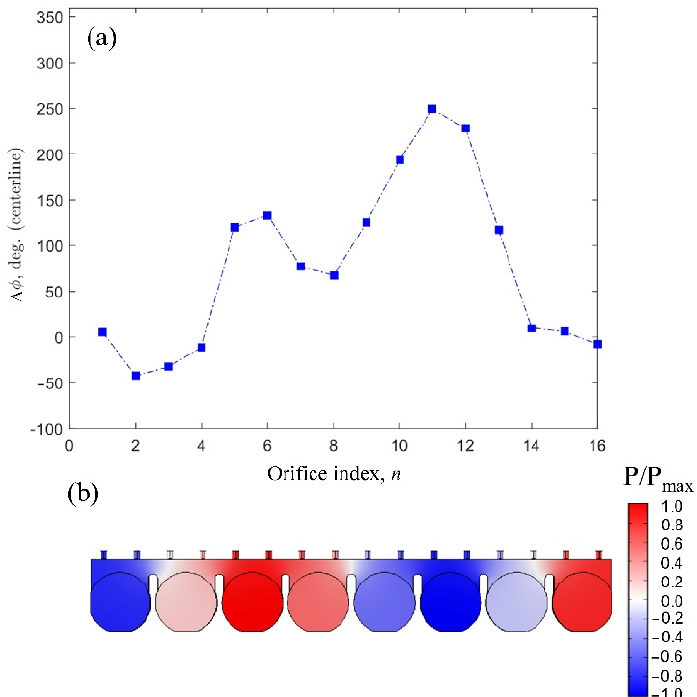
Figure 11. ( a ) Variation of the phase-angle difference between the phase-averaged peak jet velocity at the orifice centre and the peak input excitation along all 16 orifices for the excitation of the unified-cavity configuration at the frequency of f e = 800 Hz and ( b ) the variation of the instantaneous acoustic pressure within the unified-cavity volume at the closest resonance frequency of an acoustic mode ( f s = 956 Hz).